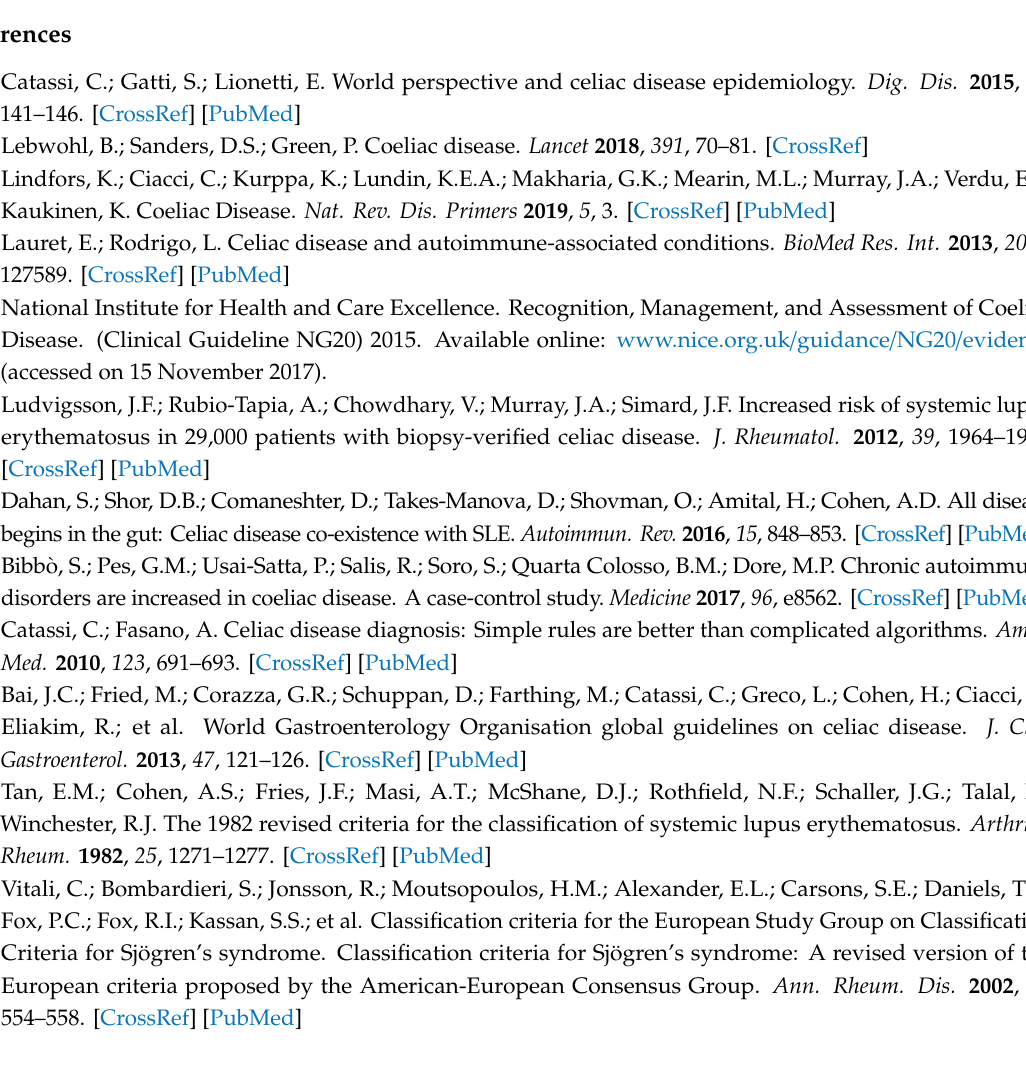
Table S1: Frequency of celiac disease-specific manifestations in the three groups of AD patients, Table S2: Frequency of clinical and laboratory features in SLE patients with CD in comparison to those without evidence of CD, Table S3: Frequency of clinical and laboratory features in pSS patients with CD in comparison to those without evidence of CD, Table S4: Frequency of clinical and laboratory features in SSc patients with CD in comparison to those without evidence of